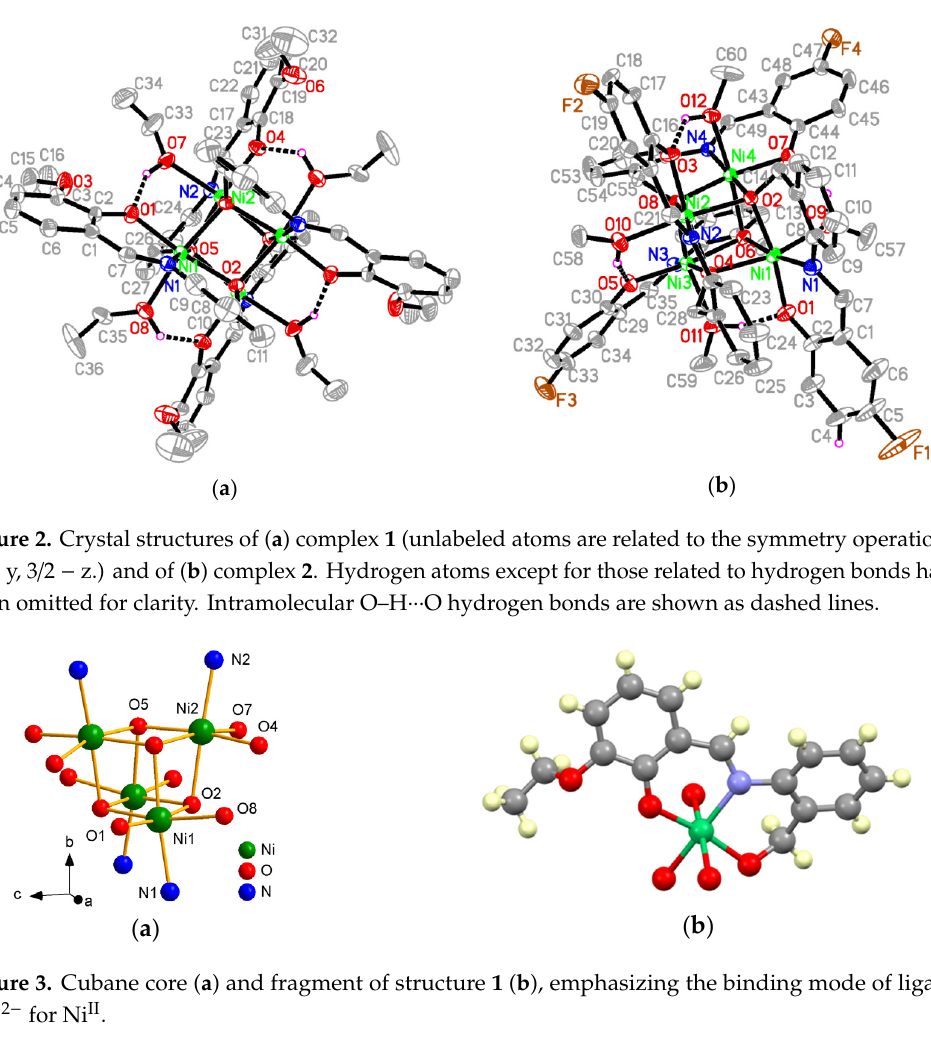
( b ) Figure 4. The molecular packing diagram of complex 1 ( a , viewed along the b axis) and 2 ( b , viewed along the a axis). Intramolecular O–H···O hydrogen and intermolecular C–H···F interactions are shown as dashed lines.